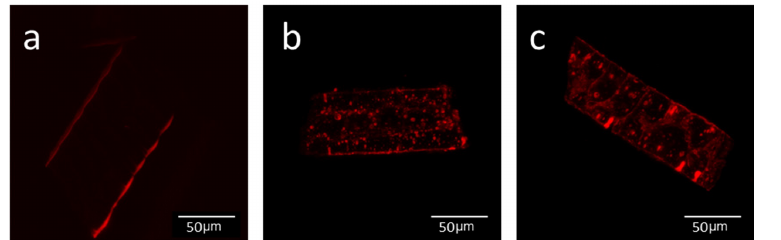
Figure 3. Confocal Fluorescence Microscopy of the internal of a non-porous HCPEG ( a ) and of a porous HCPEG matrix taken 5 min ( b ) and 30 min ( c ) after immersion in sulforhodamine B solution (1 mg/mL). The red color indicates the sulforhodamine